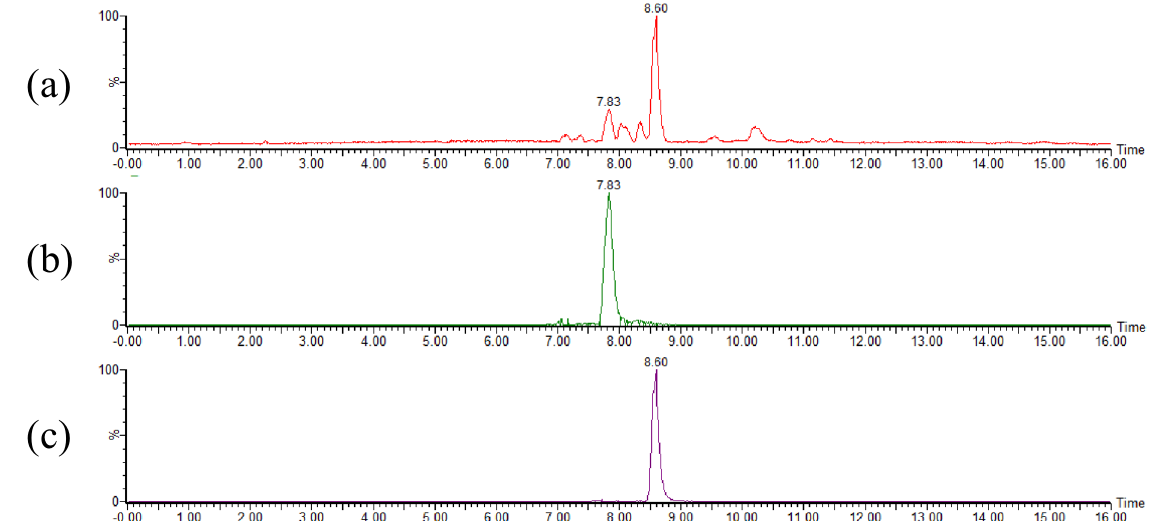
Figure 3. Typical chromatograms obtained during the UPLC-Tof/MS analysis of heated canola oil (underivatized with ADAM). The heating of canola oil was performed at 180 °C for 6 h. Base peak ion chromatogram ( a ). Extracted ion chromatogram ( b , at m/z 787.6088; c , at m/z 789.6248). Each peak is annotated with the retention